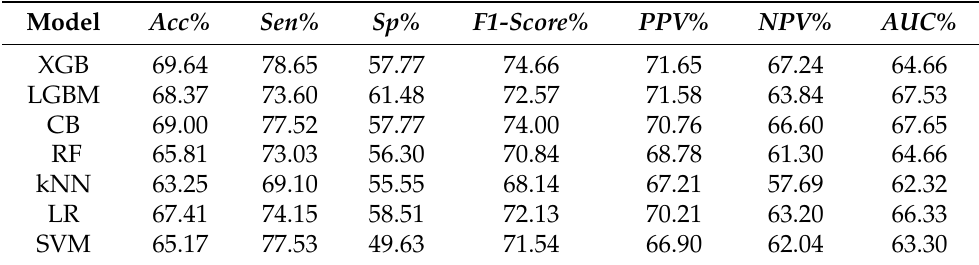
Table 2. Classification performance measures across ensemble and traditional models for 19 EHR features.